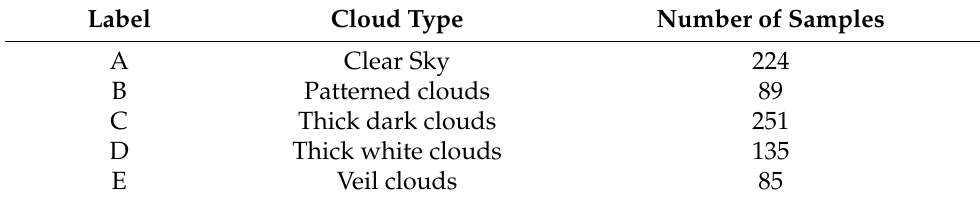
Table 3. Details of SWIMCAT